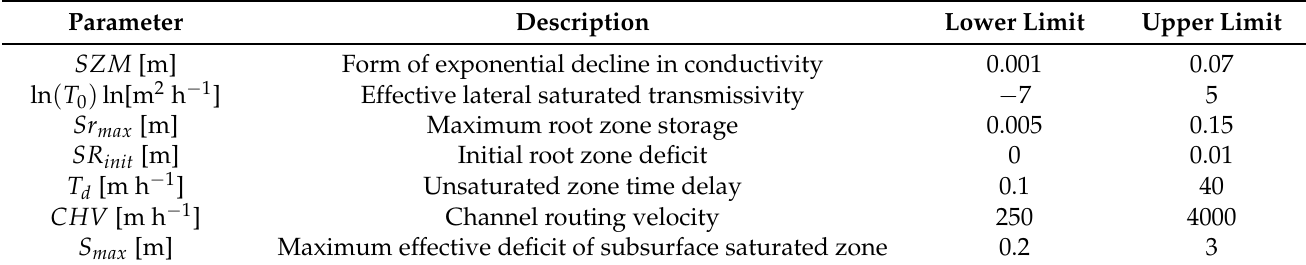
Table 1. The dynamic TOPMODEL parameters